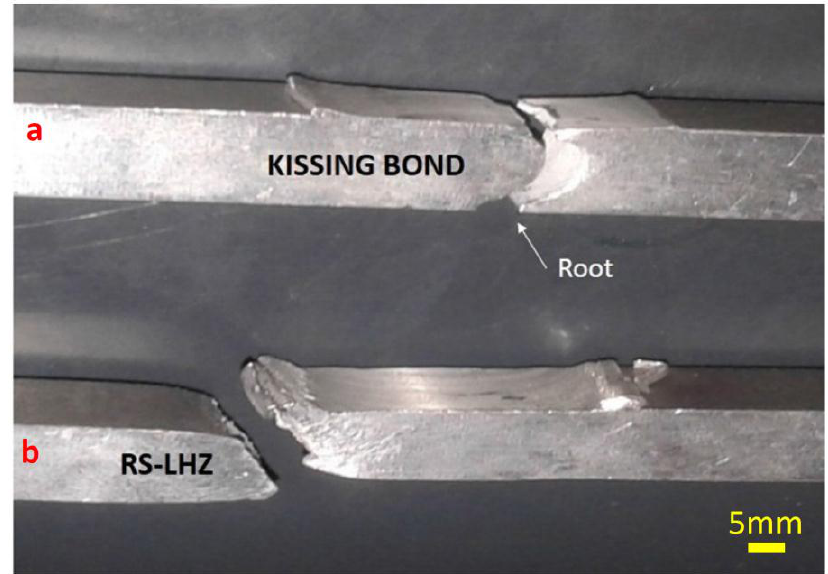
Figure 14. Fracture location: (a) As-weld; and (b) Machined.